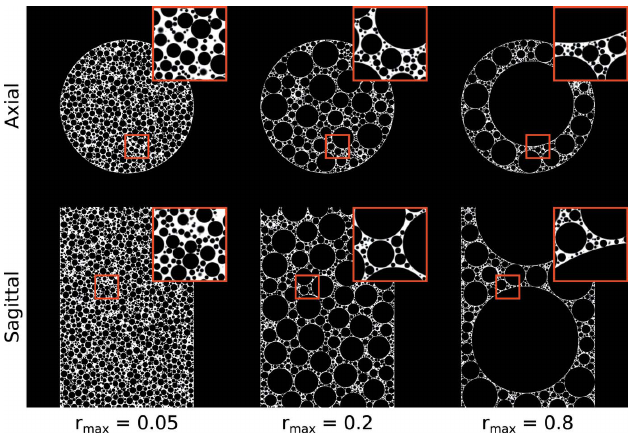
Figure 5 Generated foam phantoms with various values of the maximum possible void radius r max . Given are the central axial slice and central sagittal ( i.e. vertical) slice. A small region, indicated in red, is shown enlarged in the top right corner of each image.